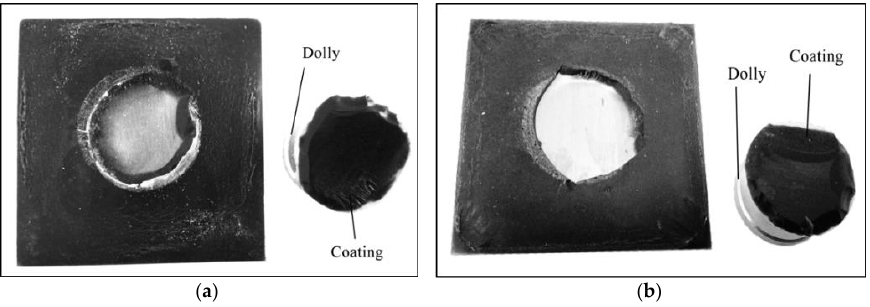
Figure 9. Adhesive failure on ( a ) sample S17 and ( b ) sample S26.